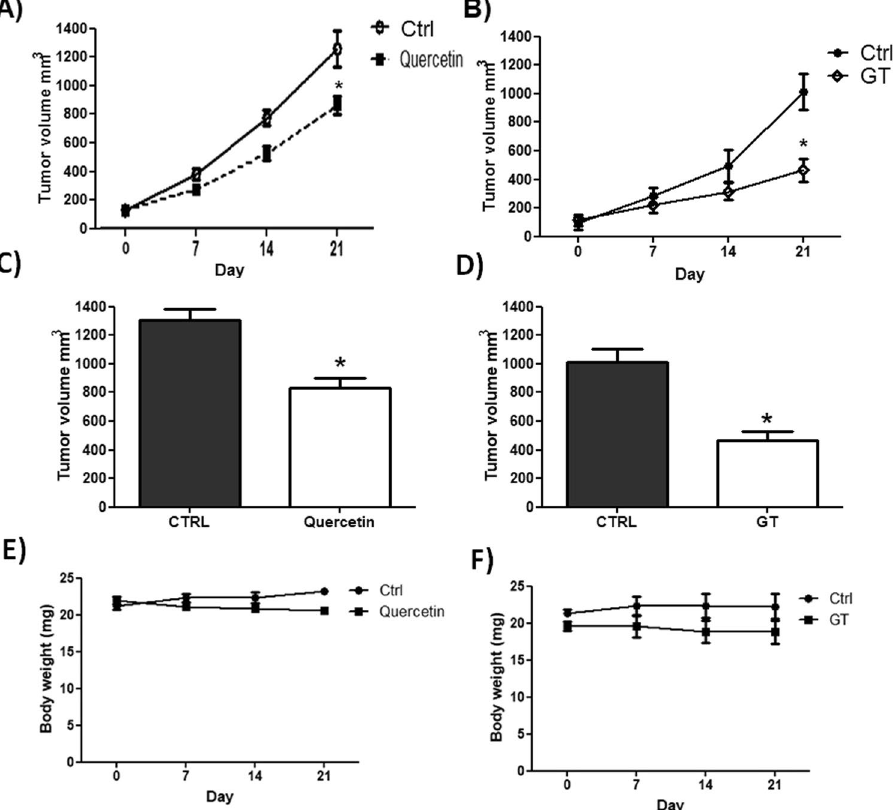
Figure 1. Quercetin ( A ) and ( B ) Green tea reduce tumor growth in HL60 xenografts. ( C ) Quercetin ( D ) and Green tea tumor volume after 21 days of treatment. The body weights of the xenograft mice treated with Quercetin ( E ) and Green tea ( F ). NOD/SCID mice with HL-60 tumors were treated or not with quercetin (120 mg/kg) once every 4 days or green tea (100 mg/kg) every day during 21 days. Every 7 days the